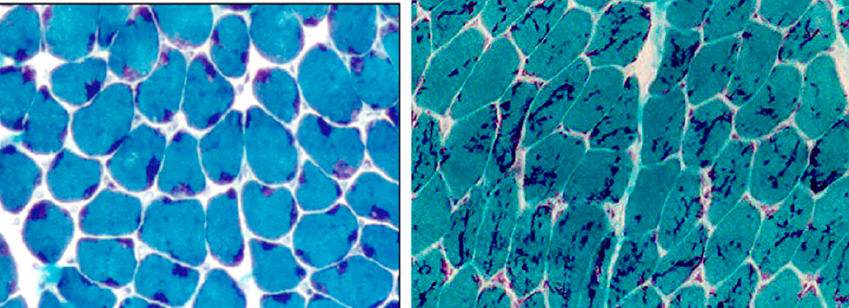
Figure 1. Muscle biopsy showing the presence and distribution of nemaline bodies inside myofibers: on the left picture, from P1, there are predominantly large rods in subsarcolemmal region; on the right picture, from P20, there are predominantly small intermyofibrillar rods (magnification ×20). Among the 30 patients, 20 individuals (P1, P2, P3, P5, P6, P7, P8, P10, P14, P15, P16, P17, P20, P21, P23, P24, P25, P26, P29, P30) were followed over months to years (six months to ten years) in a neuromuscular outpatient clinic by multidisciplinary teams. Serial cardiac evaluations performed in these 20 patients over a period of up to ten years did not indicate any cardiac abnormalities. Three patients died with respiratory complications (P10, P20 and P26). 2.2. Molecular Data We identified pathogenic mutations in NM-related genes in all 25 studied families. NEB variants were present in 20 patients (P9–P28) from 16 families (all patients had two NEB variants). Five families showed heterozygous mutations in the ACTA1 gene (P1–P5). In addition, in four families, mutations in the following genes were found: TPM2 (P6), TPM3 (P7/P8) and KLHL40 (P29, P30) (Table 1). 2.2.1. Patients with Mutations in the Nebulin Gene Among the 20 patients (16 families) with NEB mutations, 17 individuals were classified as typical (P10–P22, P25, P26) and 3 with the mild form (childhood/juvenile form) (P9, P23, P24). All families showed two nebulin mutations, including point mutations, small deletions or duplication and CNVs (P9–P28). In two families, there were two affected siblings (P11/P12 and P23/P24) carrying homozygous mutations, and family 10 (P11/P12 was consanguineous. In the other 14 families, the cases were compound heterozygous for two different NEB variations, including family 16 and 23 with two siblings. Parental segregation analysis performed in three cases confirmed the presence of the two mutations in trans (P14, P16, P17). Initially, in two families (P21 and P22), we found a mutation in only one allele of the NEB gene, but using next-generation piplines for CNV identification, we found the second mutation: duplication of exons 82 to 105 in P21 and deletion of exon 29 in P22. Additional analysis using Motor Chip v3 [41] confirmed the duplication in patient 21, and parental segregation analysis showed that the CNV was de novo. Among the total of twenty-five different identified variants in the NEB gene, ten were in the splice sites, nine were frameshift, three stop-gain, one non-frameshift duplication and two CNVs. Eleven of these variants were newly described mutations: four frameshift (c.8501delA, c.24304_24305+2T>A; c.23878_23881dup, c.3648delT), three splice site (c.20466+2T>A, c.19102-8_19102-4del; c.25405-1G>C), one stop-gain (c.16423A>T), one non-frameshift duplication (c.6869_6870insTGC) and two CNVs (exons 82–105 duplication, exon 29 deletion).